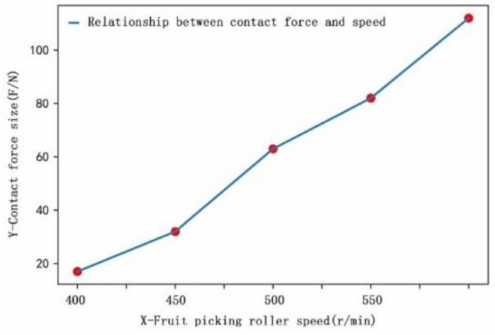
Figure 10. Contact force as a function of speed at different